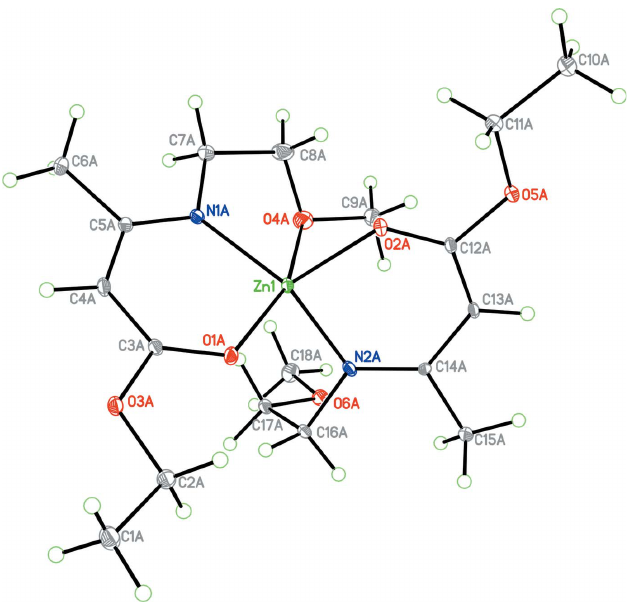
Figure 1 The molecular structure of molecule A showing the long Zn—O (ether) interaction influencing the conformation of the substituent. Atomic displacement parameters are shown at the 30% probability